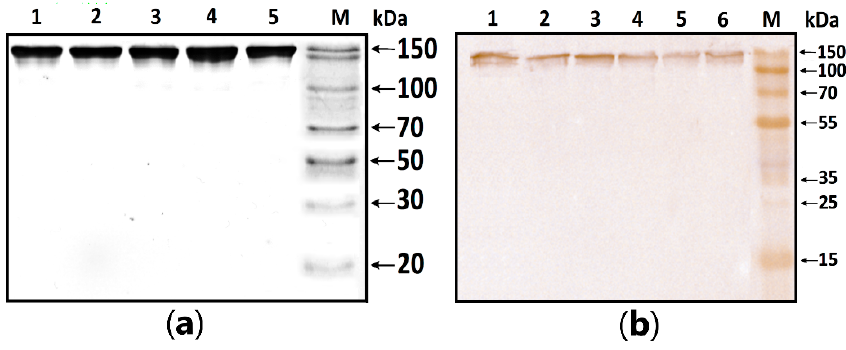
Figure 1 . ( a ) SDS-PAGE analysis of a homogeneous IgG preparation in 12.5% gel followed by silver staining. Lane 1—intact IgG preparation; lane 2—IgG preparation incubated with 40 mM DTT at 100 ◦ C (conditions for the complete reduction of disulfide bonds); lane M—protein molec- ular weight markers. ( b ) Western blotting of purified IgG. Lines 1–6: Immunostaining of purified polyclonal IgG with anti-human IgG antibody; M—protein molecular weight markers.